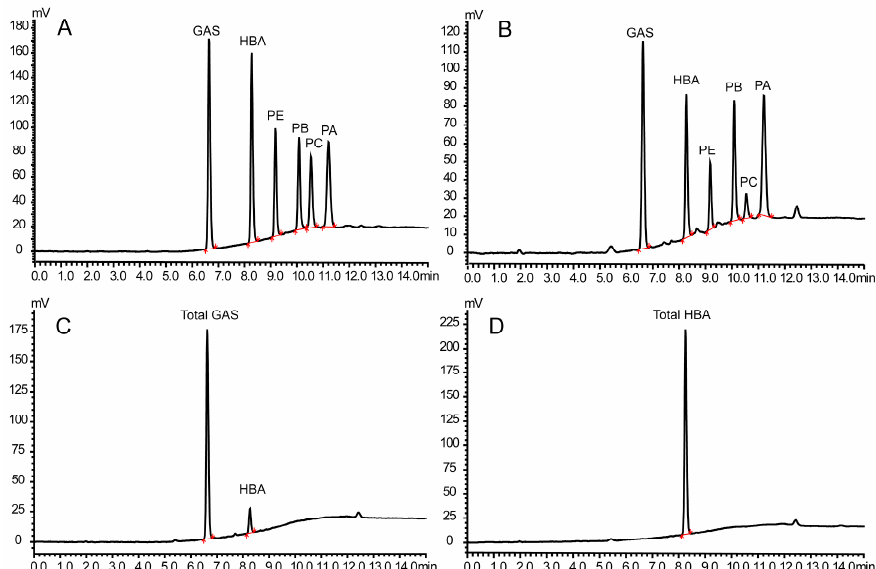
Figure 2. Representative chromatograms: ( A ) standard solution including GAS, HBA, PE, PB, PC and PA; ( B ) extract of G. elata ; ( C ) extract of G. elata after base hydrolysis; ( D ) extract of G. elata after base-enzymatic hydrolysis. The injected volume of extract of G. elata was 10 μ L, and the hydrolyzed samples was 2 μ L.